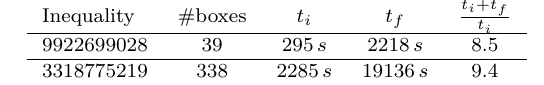
Table II. Formal Bounds Computation Results for Semialgebraic Relaxations of Flyspeck Inequal- ities